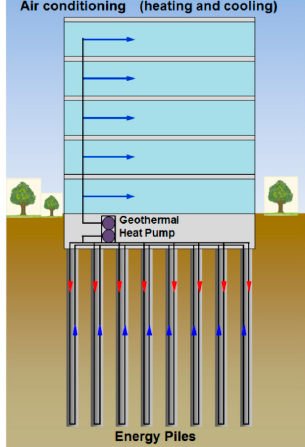
Figure 1. Schematic drawing of energy piles application in building energy efficiency [6].